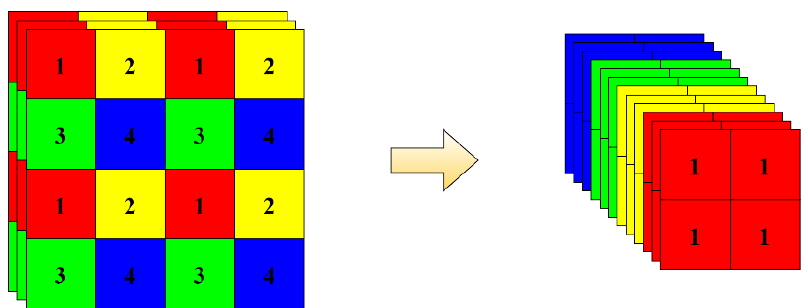
Figure 6. Focus structure slice operation.